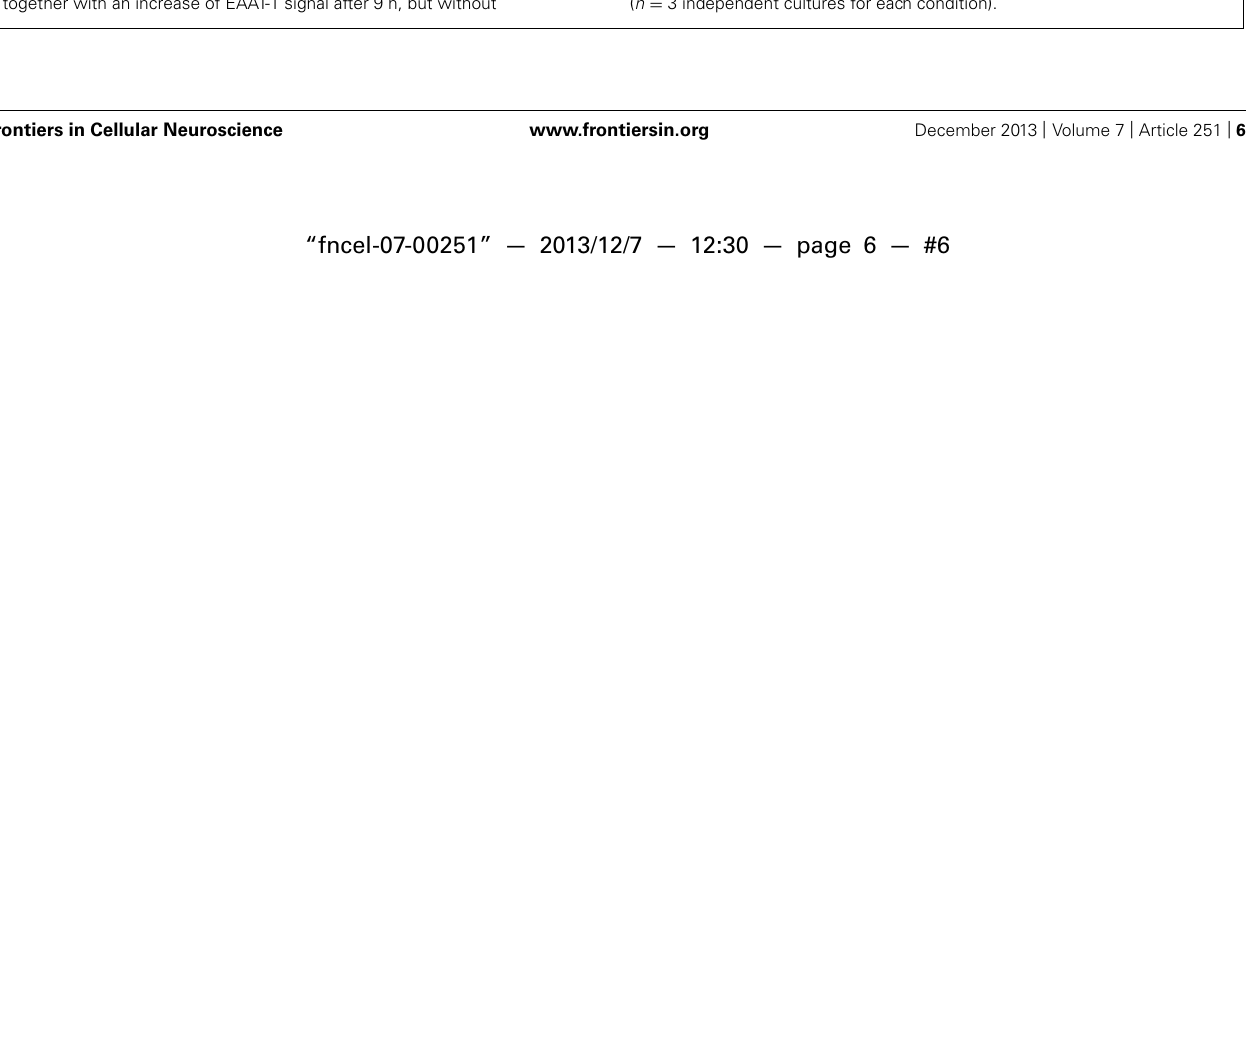
FIGURE 3 | Extracellular microvesicles from astrocytes contain functional EAAT-1. (A) Representative western blots showing NaK ATPase, EAAT-1 and glutamine synthetase in astrocyte-derived eMV, whereas only NaK ATPase is detected in eMV from microglia or serum. Lanes correspond to medium from 75 cm 2 of confluent cells. Coomassie staining (coom) shows total protein content. (B) Western blots of astrocyte (GFAP positive) and microglia (Iba-1 positive) extracts showing that both cell types express EAAT-1 in culture (10 μ g of proteins extracts loaded). (C) Bar graph showing [ 3 H] aspartate reuptake from astrocyte-conditioned medium treated (black bar) or not (white bar) with the specific EAAT blockerTF-TBOA. Given as mean ± SEM. ** p < 0.001, t -test withWelch correction, n = 3 samples from 3 independent dishes. (D) Time course study of eMV composition in response to PMA without medium replacement. An enrichment of NaK ATPase and glutamine synthetase is found at 6 and 9 h post-treatment together with an increase of EAAT-1 signal after 9 h, but